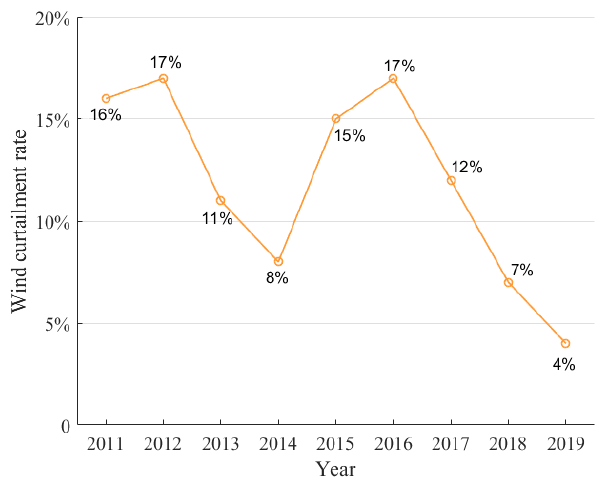
Figure 2. Wind curtailment rate.